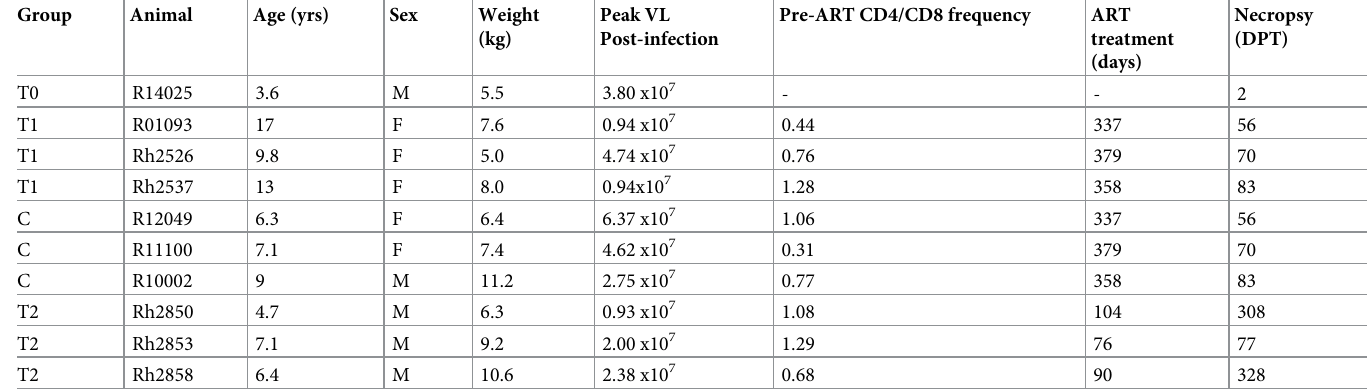
Table 1. Animal information.